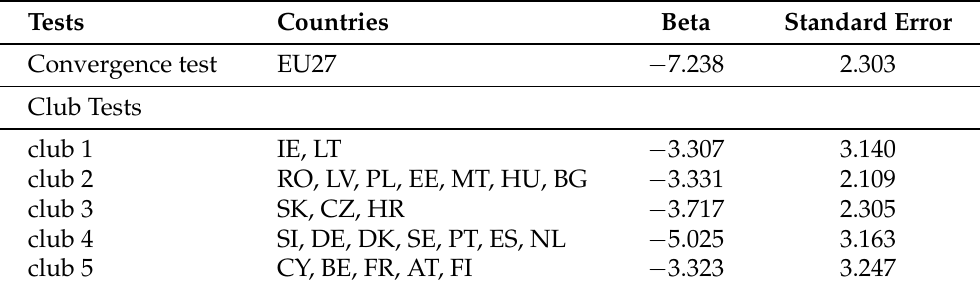
Table 1. Club Convergence